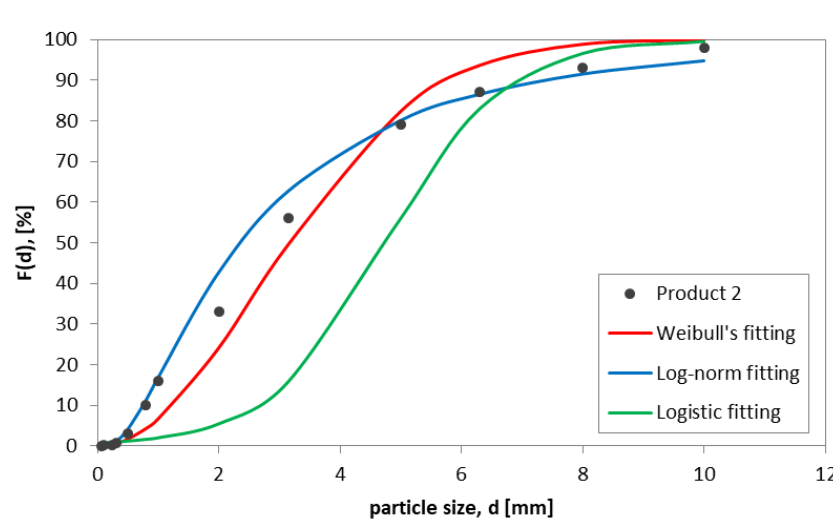
Figure 3. Fitting results for product 1.